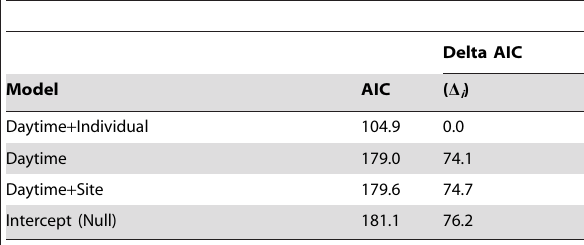
Table 2. AIC values for Poisson GLMs, predicting prey- capture attempt frequency.